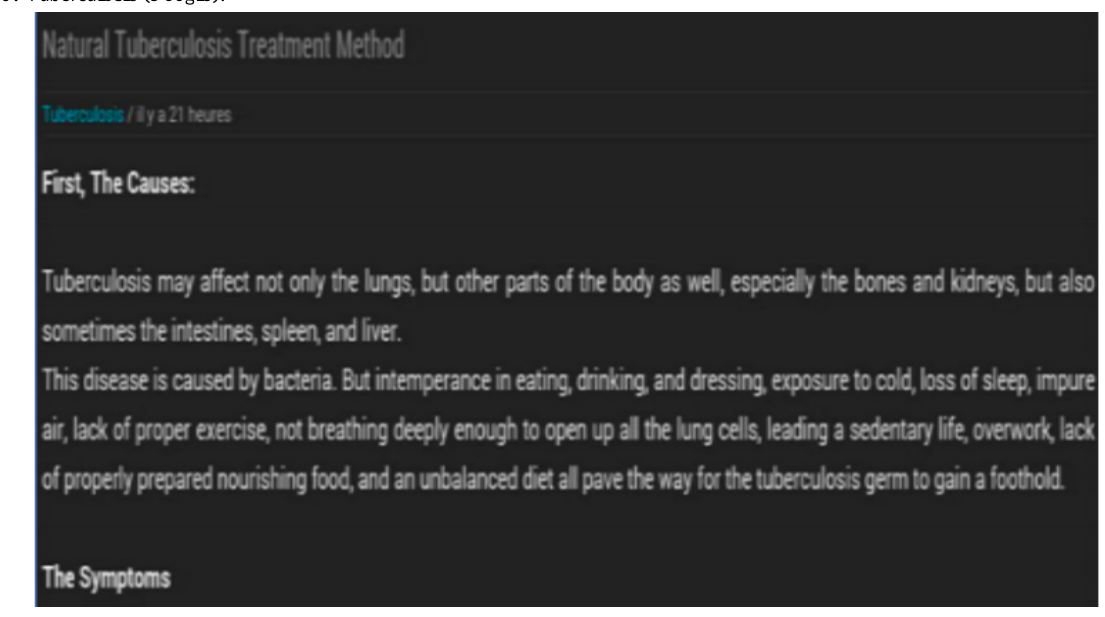
Figure 6. Tuberculosis